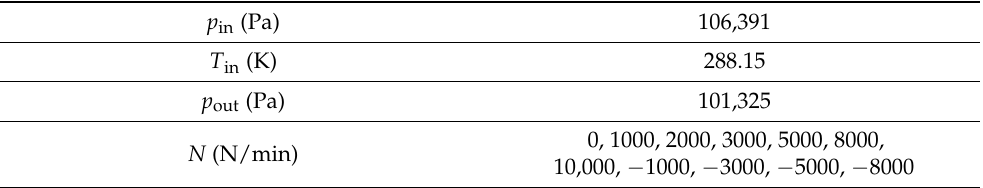
Table 3. Boundary